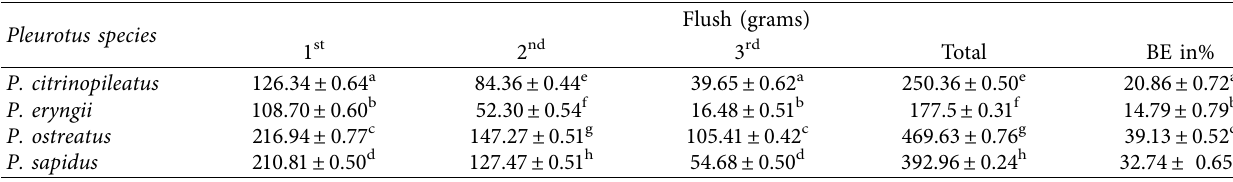
Table 3: Yield and biological efficiency of the four Pleurotus species on noncomposted coffee parchment substrate. Pleurotus species